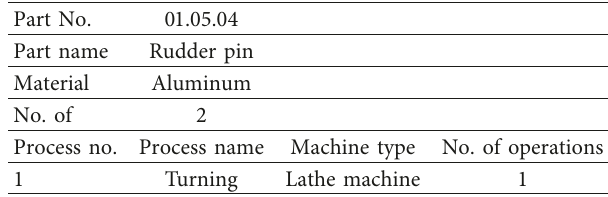
Table 15: Rudder pin.